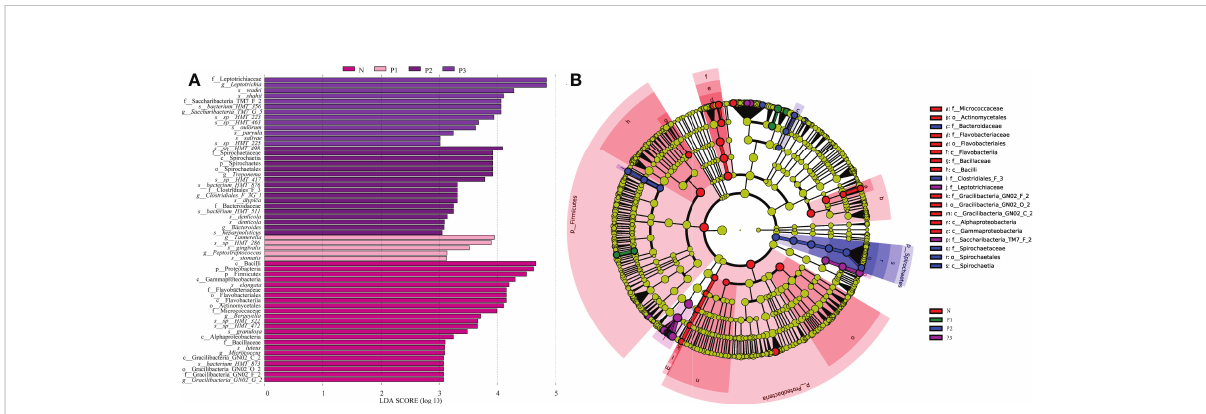
(Figure 5B). PICRUSt2 predicted 172 level 3 functional pathways by comparison with KEGG immediate relatives (Additional File 1: Table S10, Additional File 2: Figure